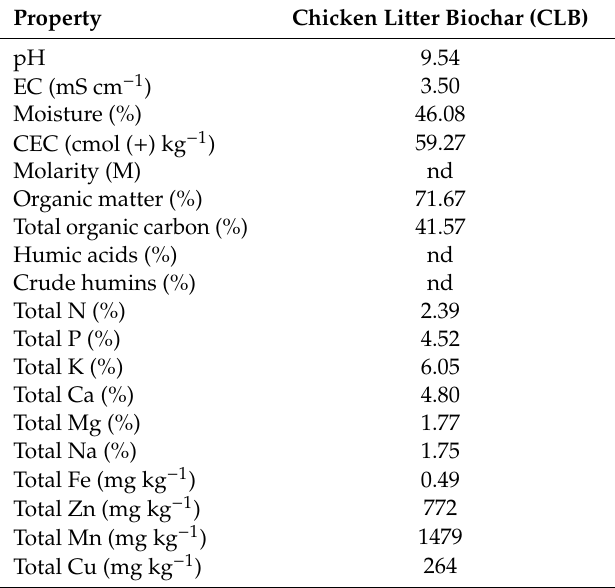
Table 2. Selected chemical properties of chicken litter